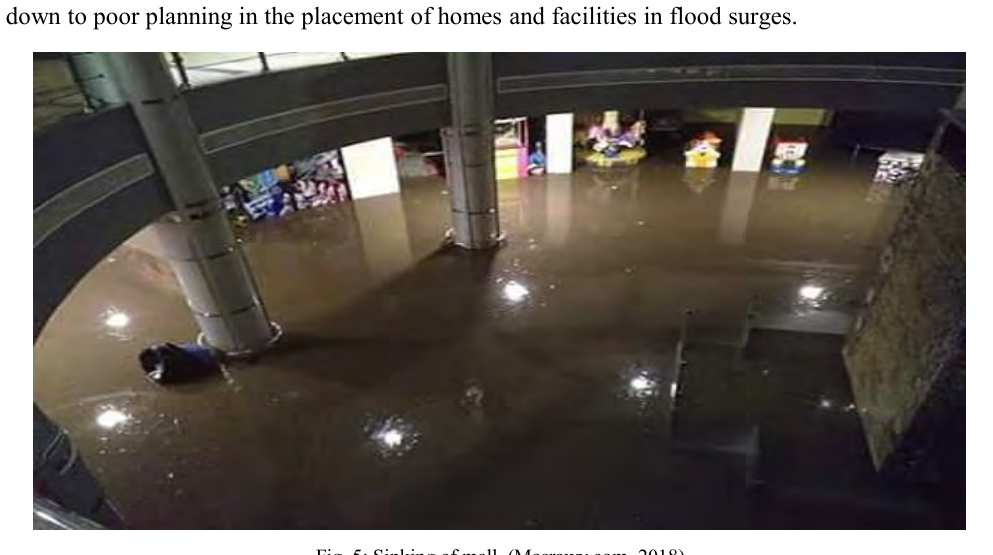
Fig. 5: Sinking of mall. (Masrawy.com, 2018)